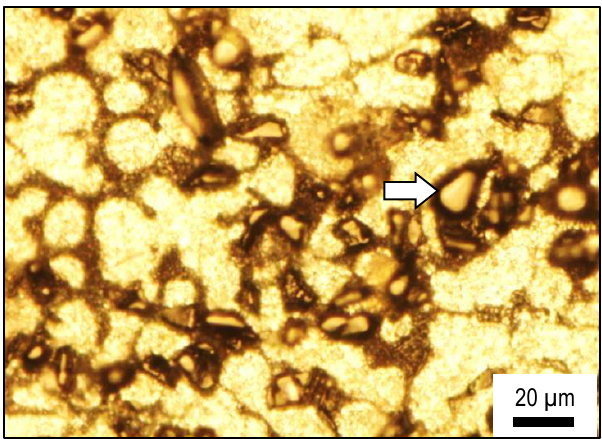
Figure 8: Microstructure of the welded region of A359/SiC/10p. Notice the absence of needle-shape Al 4 C 3 near a SiC particle (at arrow). Preheating and GTAW at 85A AC, 260 mm/min.